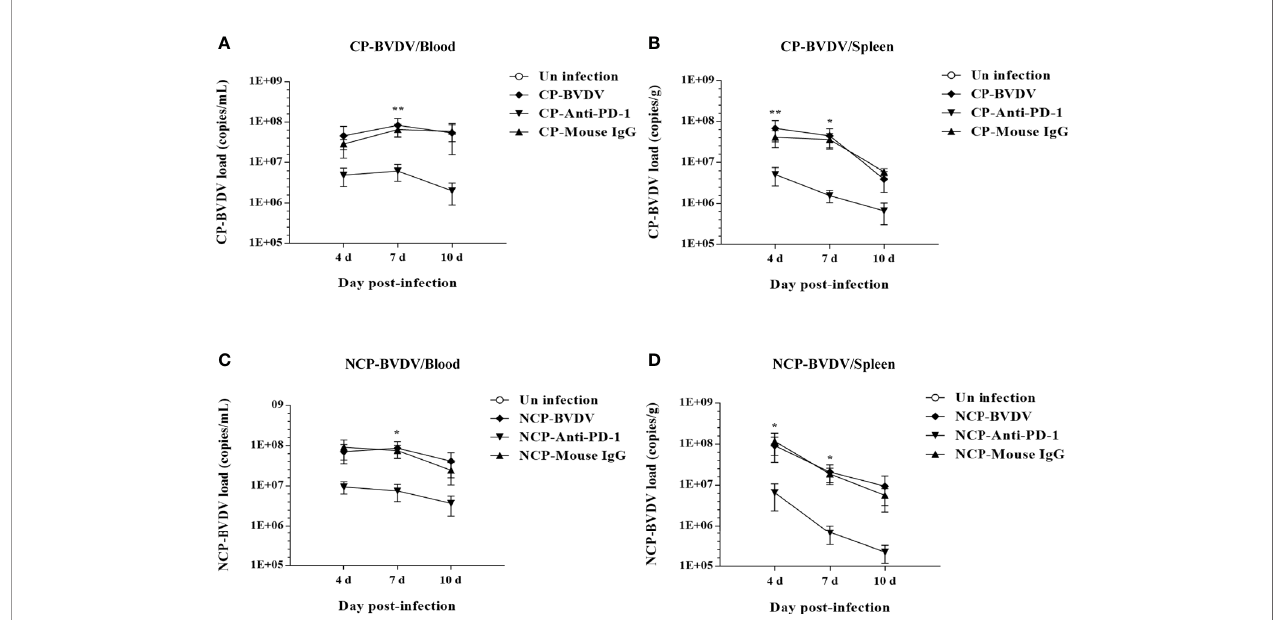
FIGURE 13 | Effect of PD-1 blockade on virus replication in the blood and spleen of BVDV-infected mice at day 7 of post-infection. (A) the replication of the CP BVDV in blood. (B) the replication of the CP BVDV in spleen. (C) the replication of the NCP BVDV in blood. (D) the replication of the NCP BVDV in spleen. ** p < 0.01, * p < 0.05. The animals were assigned into 7 experimental groups, including the mock-infected group, CP BVDV-infected group, CP BVDV+anti-PD-1 group, CP BVDV+mouse IgG group, NCP BVDV-infected group, NCP BVDV+anti-PD-1 group, and NCP BVDV+mouse IgG group. CP and NCP BVDV-infected mice were used as the controls. Data are presented as mean ± SD (n = 5 per group) and analyzed using two-way